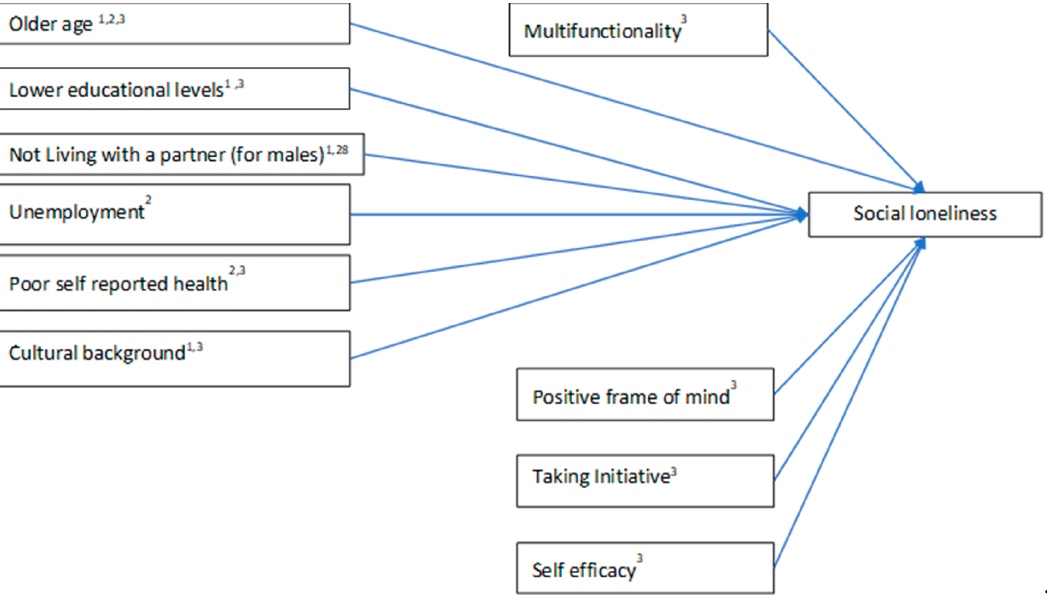
Figure 3. Antecedents to social loneliness. 1. Fierloos et al. (2021); 2. Gibney et al. (2019); 3. Nieboer et al. (2020); 28. Evans et al. (2019).